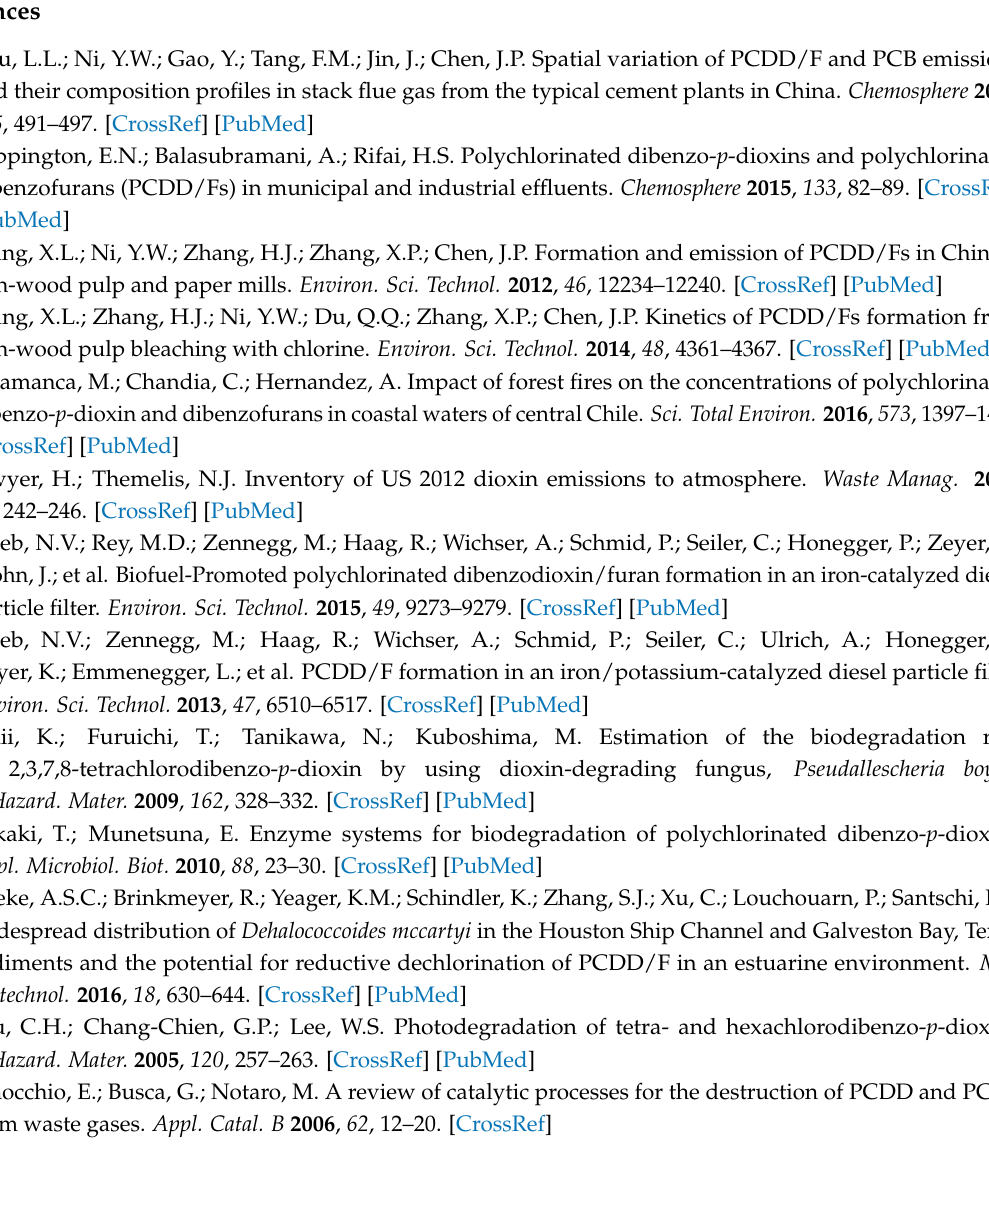
Supplementary Materials: Supplementary Materials are available online. Figure S1: The schematic maps for the relative energy of products relative to TCDD and CH radical. Figure S2: Optimized IMs, TSs, and products in the reactions of F- and Br-substituted TCDDs with CH radical. Table S1: Topological parameters for the selected BCPs in the initial intermediates and products. Table S2: Cartesian coordinates of the species in the possible